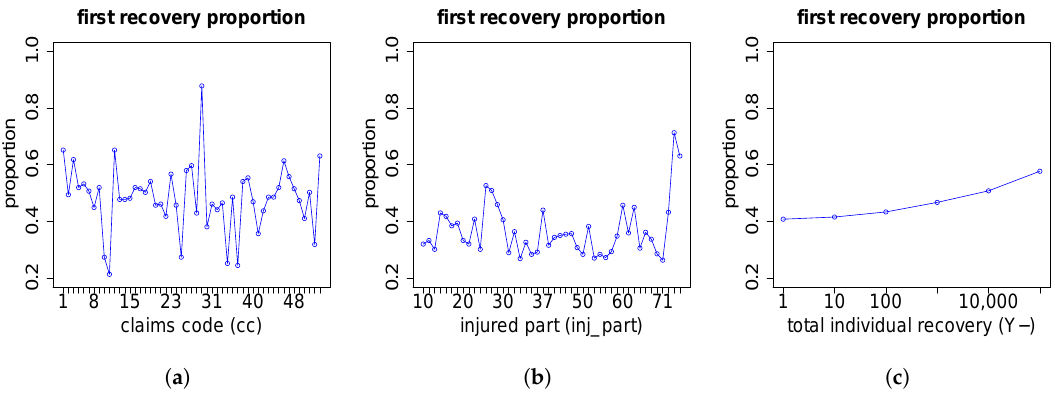
Figure A14. Proportion P − of the total individual recovery Y − paid in the first recovery payment in the case of K − = 2 recovery payments w.r.t. the features ( a ) cc ; ( b ) inj_part and ( c ) total individual recovery Y − .